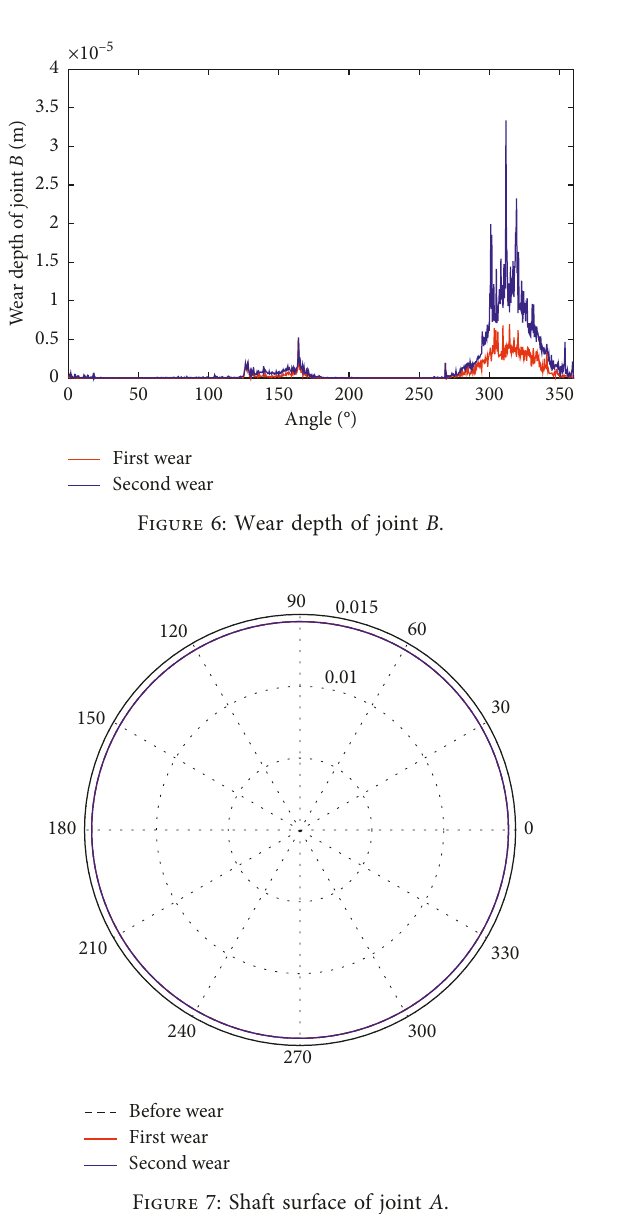
Figure 7: Shaft surface of joint A .